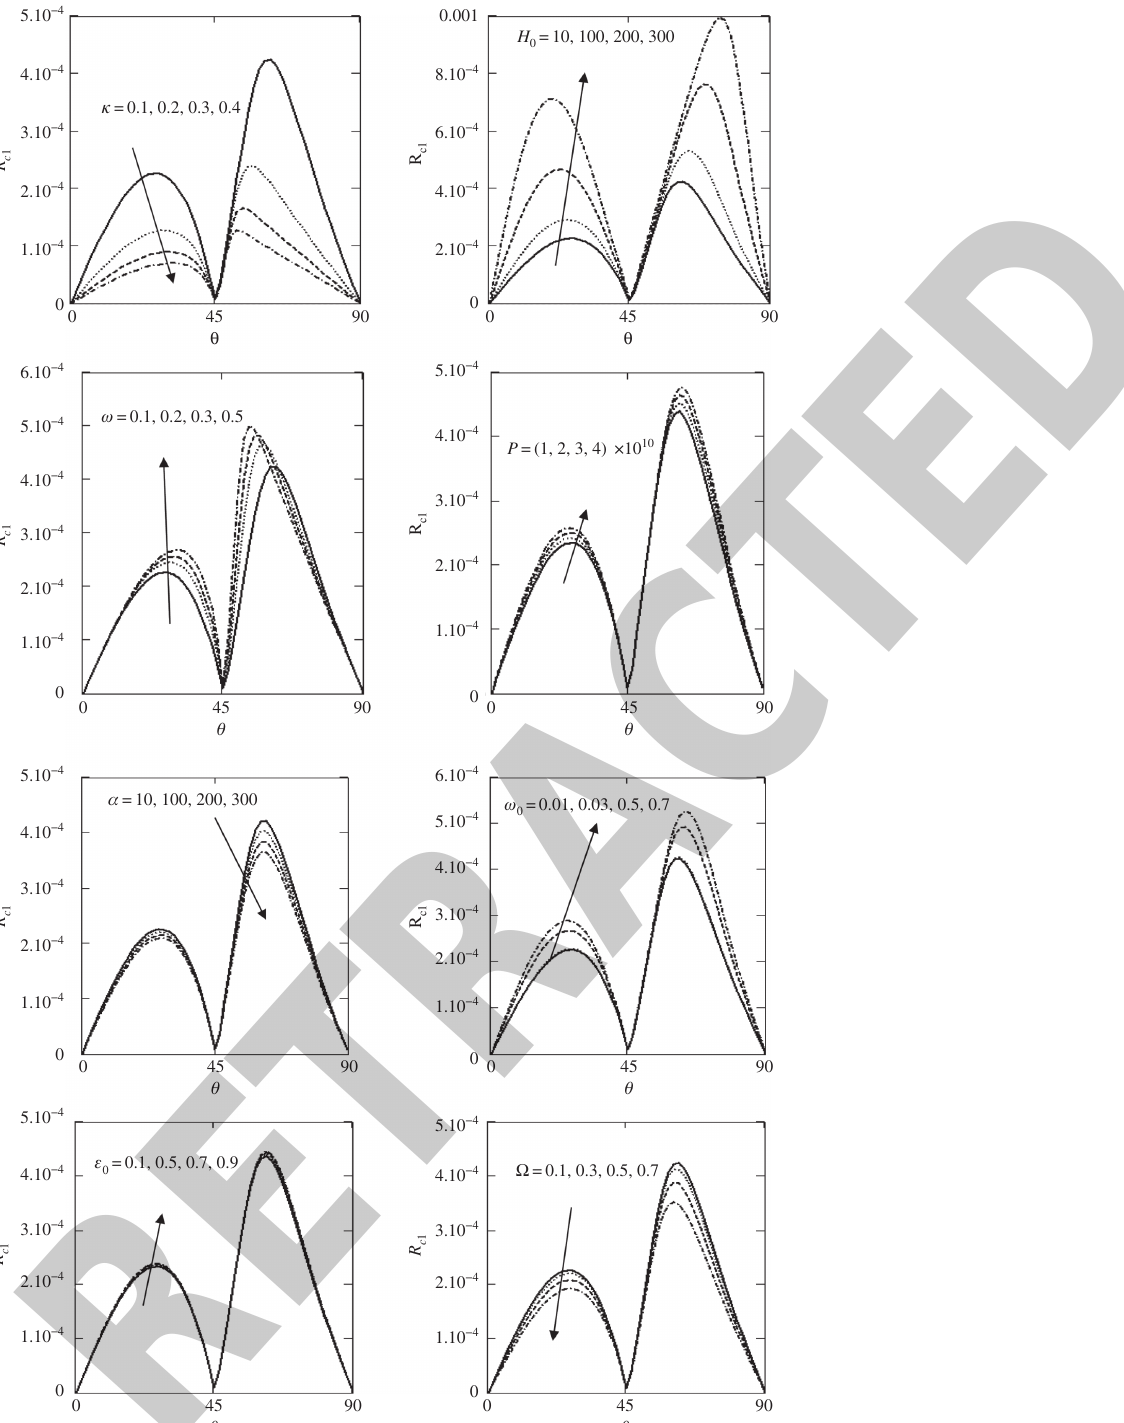
, ω , P , α , ω , ε , and Ω with respect to 0 0 0